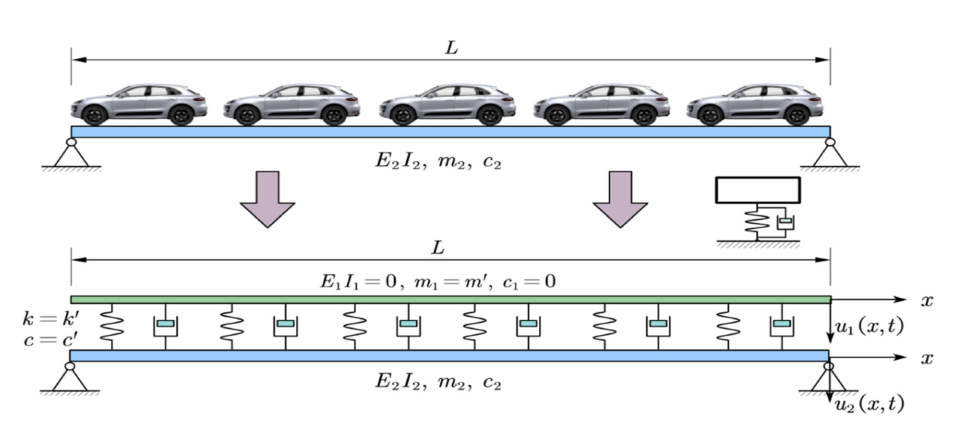
Figure 2. Simplified schematic of a VBI